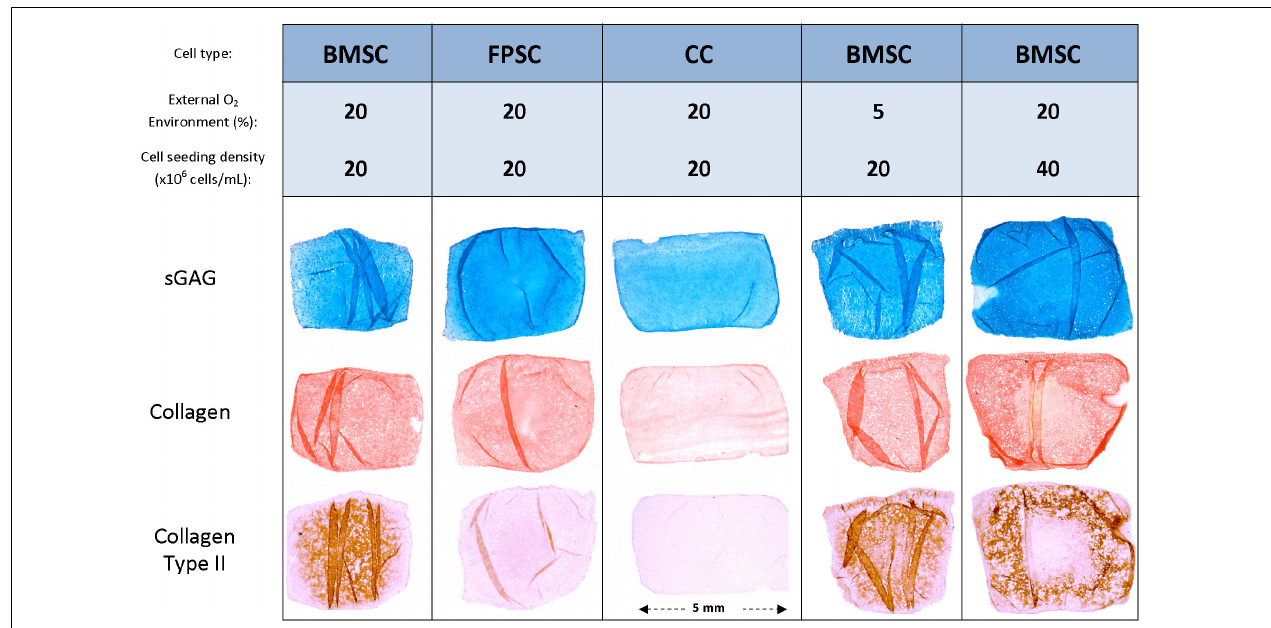
FIGURE 5 | Histological and immuno-histochemical staining was performed on representative sections of cartilage tissue grafts engineered using various cell sources and cultured for 24 days.